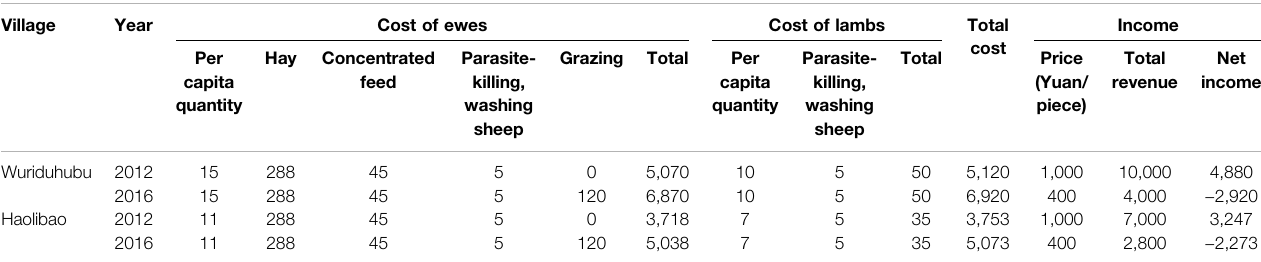
TABLE 6 | The cost and income of rearing sheep in herder